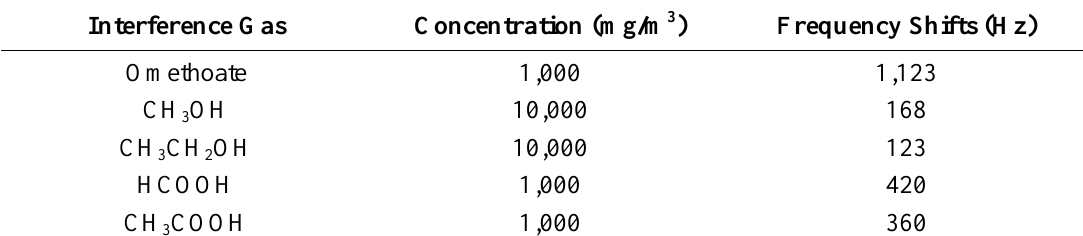
Table 2. Response of the SAW-MIP sensor to